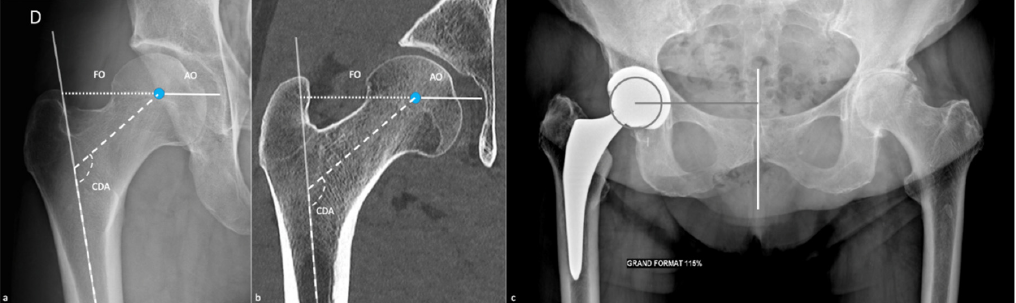
Figure 1. Preoperative measurements. Those values can be measured on ( a ) an anteroposterior pelvic radiograph and on ( b ) a coronal CT image, in the plane established by the femoral neck axis and the femoral midshaft. AO corresponds to the acetabular offset (white line: distance between the femoral head center (blue circle) and the acetabular floor), FO to the femoral offset (little-dotted line: distance between the femoral head center and the femoral midshaft axis (mild transparent white line)), CDA to the cervico-diaphyseal angle (large-dotted white line). A measurement of AO from the pelvic midline is shown on ( c ) an AP pelvic view [21], as it is more suitable in case of hip prosthesis, especially in case of cup protrusion.